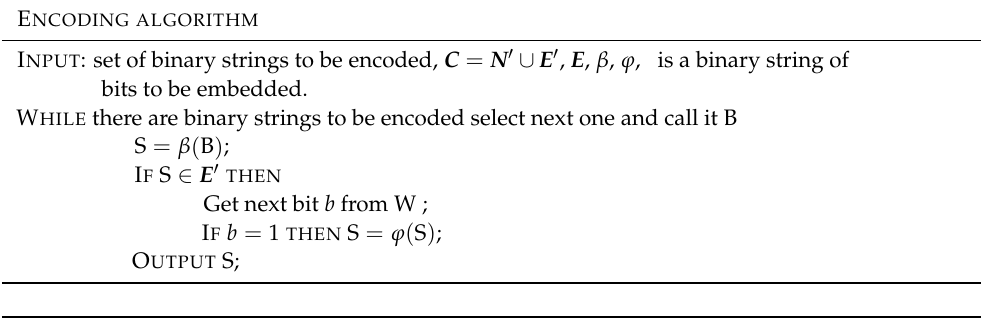
Algorithm 2: Pseudo-code of the decoding algorithm D ECODING